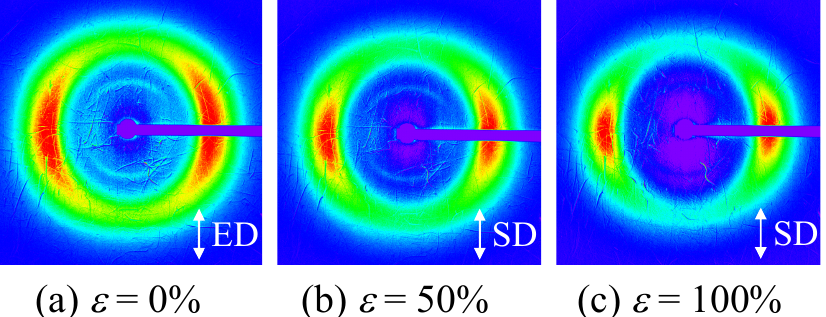
Figure 9. Two-dimensional WAXD patterns of the heat-elongated TPU film ( λ = 300%) during uniaxial stretching at 23 ◦ C at various strains ε ; ( a ) ε = 0%, ( b ) ε = 50%, ( c ) ε = 100%.